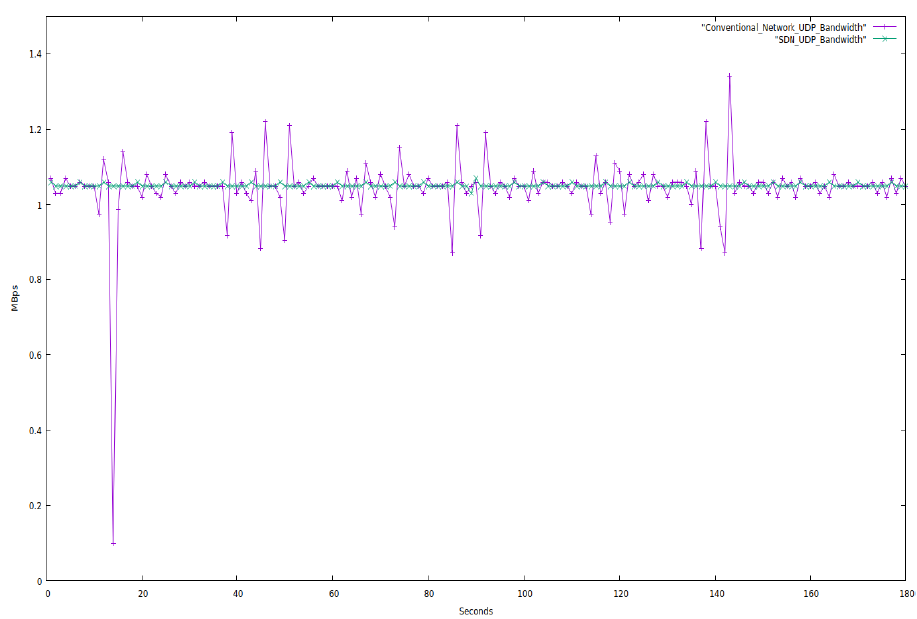
Figure 8. UDP Bandwidth Fluctuation of SDN vs. Traditional Network.